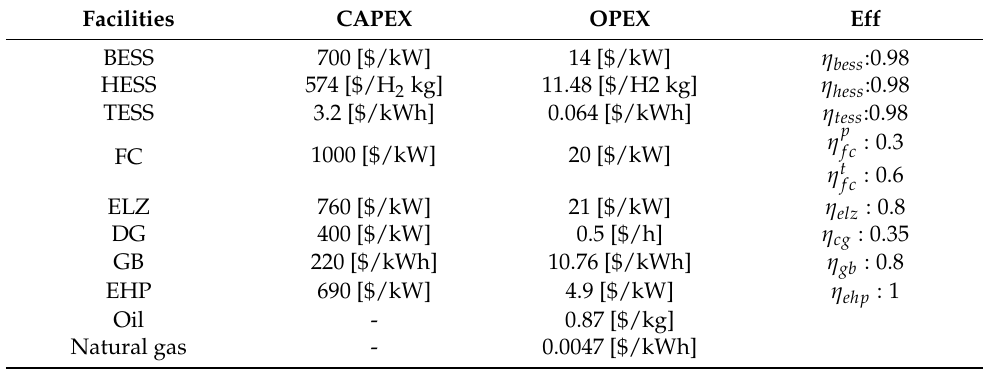
Table 2. Facilities economical parameters.